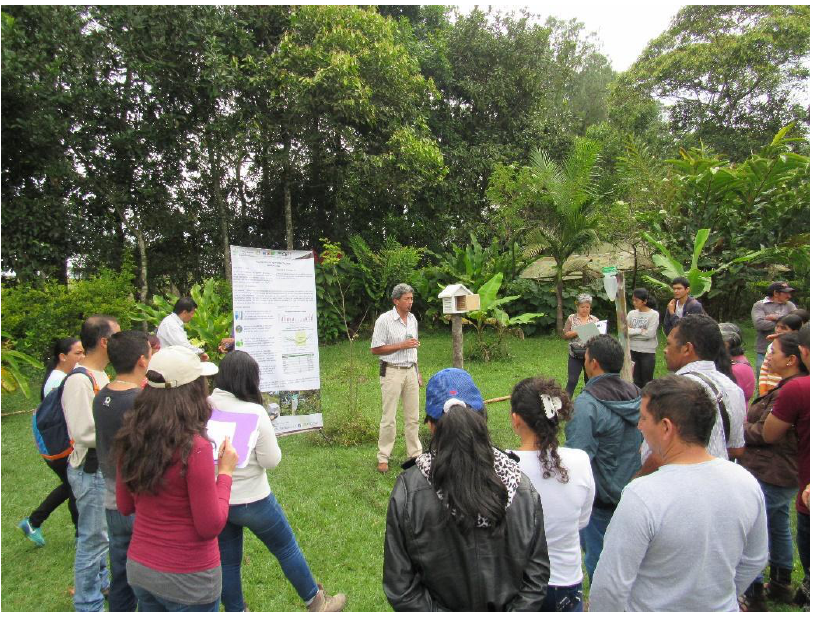
Figure 3. Meeting of farmers of the project farms. Source: